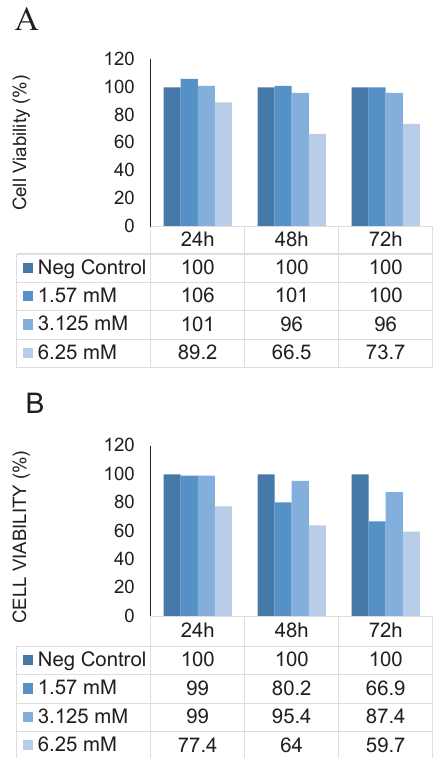
Figure 2. In vitro cell viability assessment of (A) FeSO 4 -bulk and (B) FeSO 4 -NPs on HT-29 cells after 24, 48, 72 h by MTT assay.